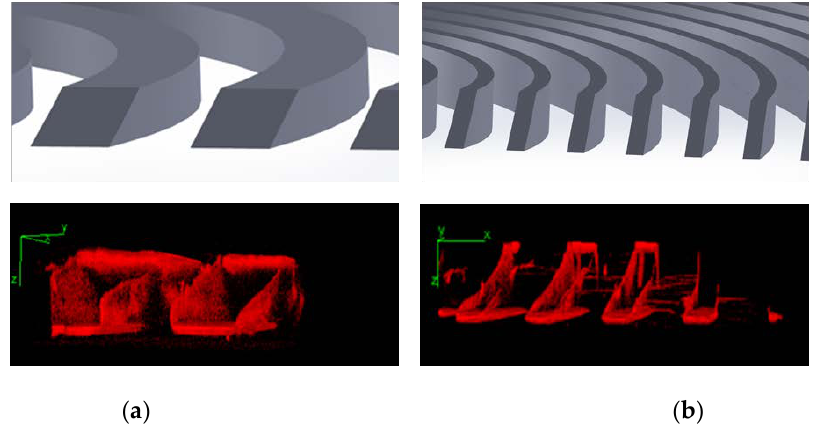
Figure 6. Check for surface availability for microRNA adsorption. Panel ( a ): 1200 ng of miR-1246-TAMRA diluted in water are adsorbed on functionalized microdevice A. Panel ( b ): 600 ng of miR-1246-TAMRA diluted in water are adsorbed on functionalized microdevice B. After washes, the dry channels were cut diagonally with an angle of about 30°, as depicted on top of each image (CAD representations), and imaged at the confocal microscope in z-stacking mode. Images are 3D reconstructions of microdevice